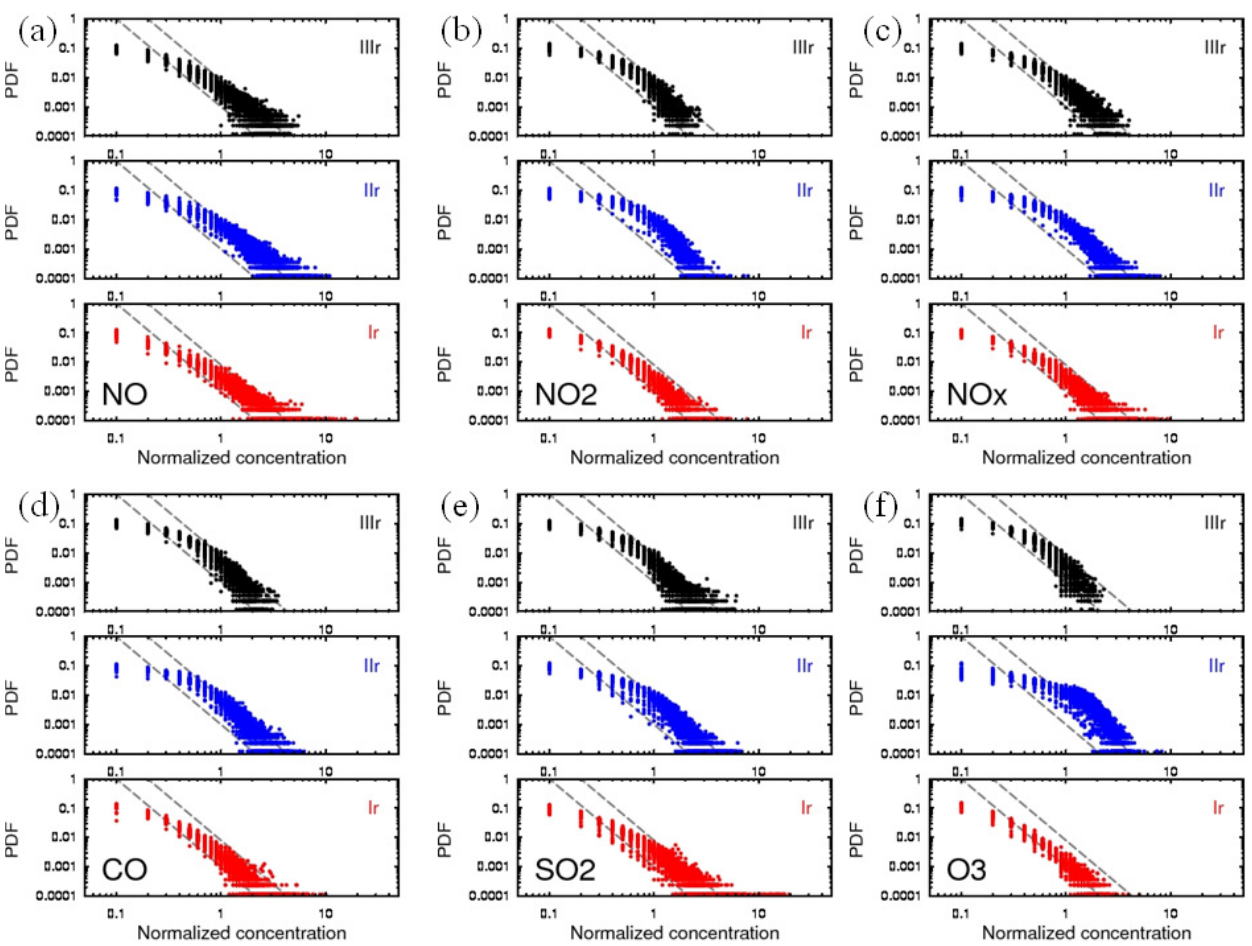
Fig. 10. Same as in Fig. 9 except only the positive sides of the PDFs plotted in the log-log scale. The grey dash line has an exponent of −